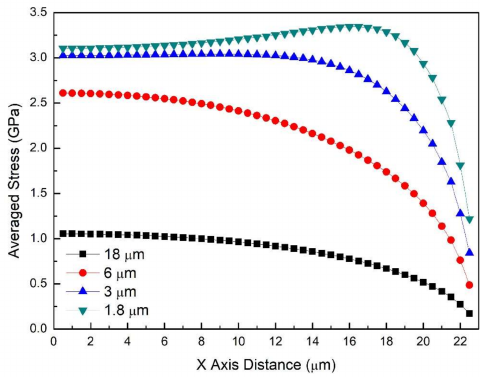
Figure 9. The TIS distribution in films of 1.8, 3, 6, and 18 µ m thick.